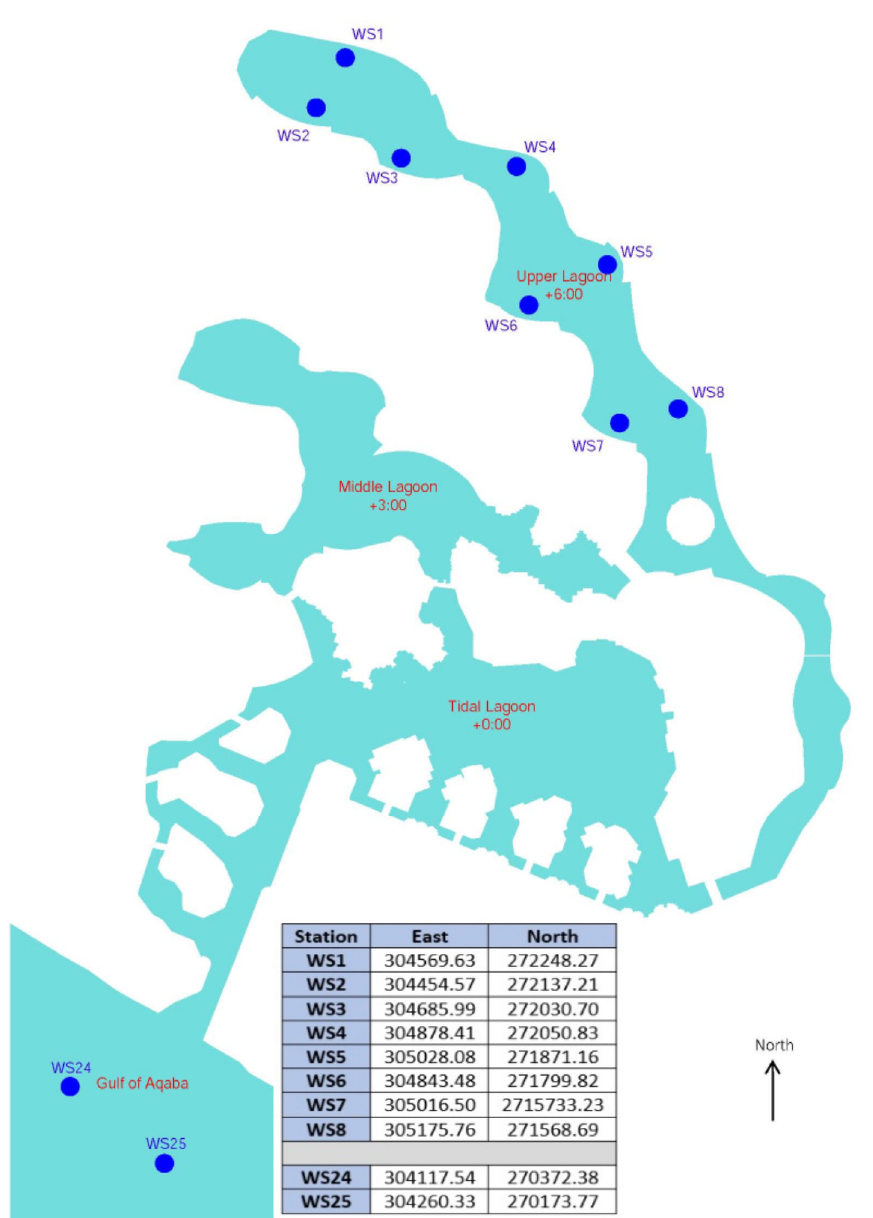
Figure 2. Map illustrating the locations of water sampling stations. Water samples collected from stations WS1 through WS8 inside the upper lagoon (UL). The two offshore stations WS24 (pumping station) and WS25 located outside the lagoons were used as reference stations, representing the ambient conditions in the Gulf of Aqaba (GoA) seawater.